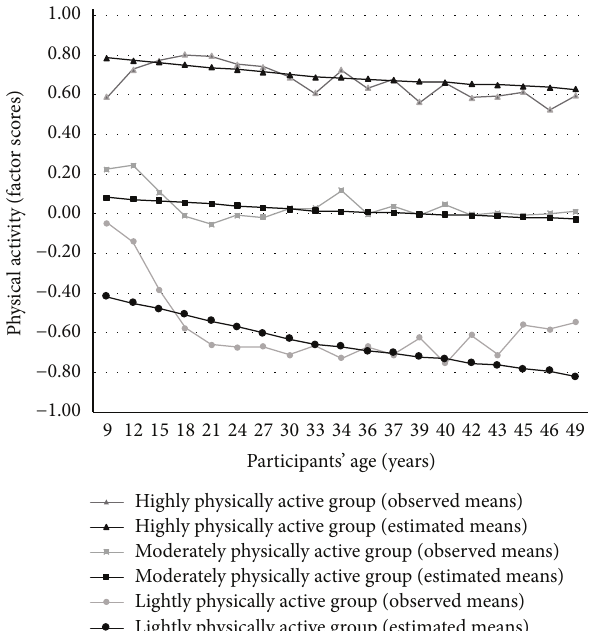
Figure 1: Means of the highly physically active ( 𝑛 = 147), moderately physically active ( 𝑛 = 3046), and lightly physically active ( 𝑛 = 371) trajectory groups from childhood to middle